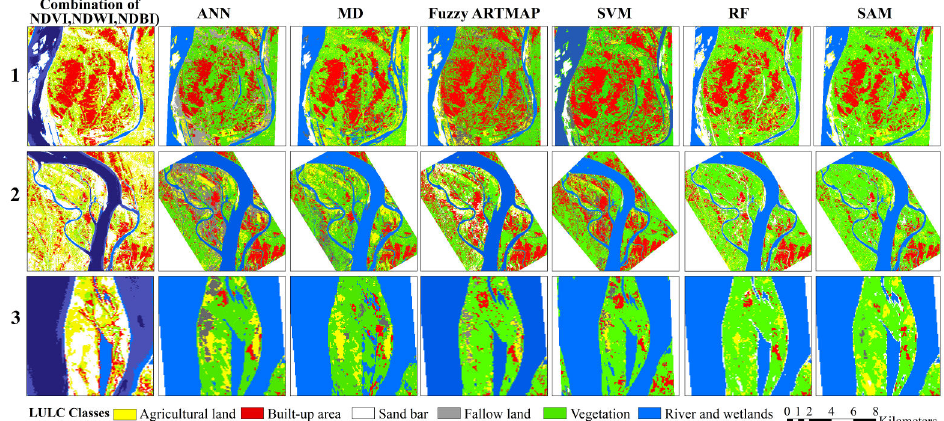
Figure 5. Validation of LULC of di ff erent classifiers with satellite data-derived indices (normalized di ff erential vegetation index (NDVI), normalized di ff erential water index (NDWI), and normalized di ff erential built-up index